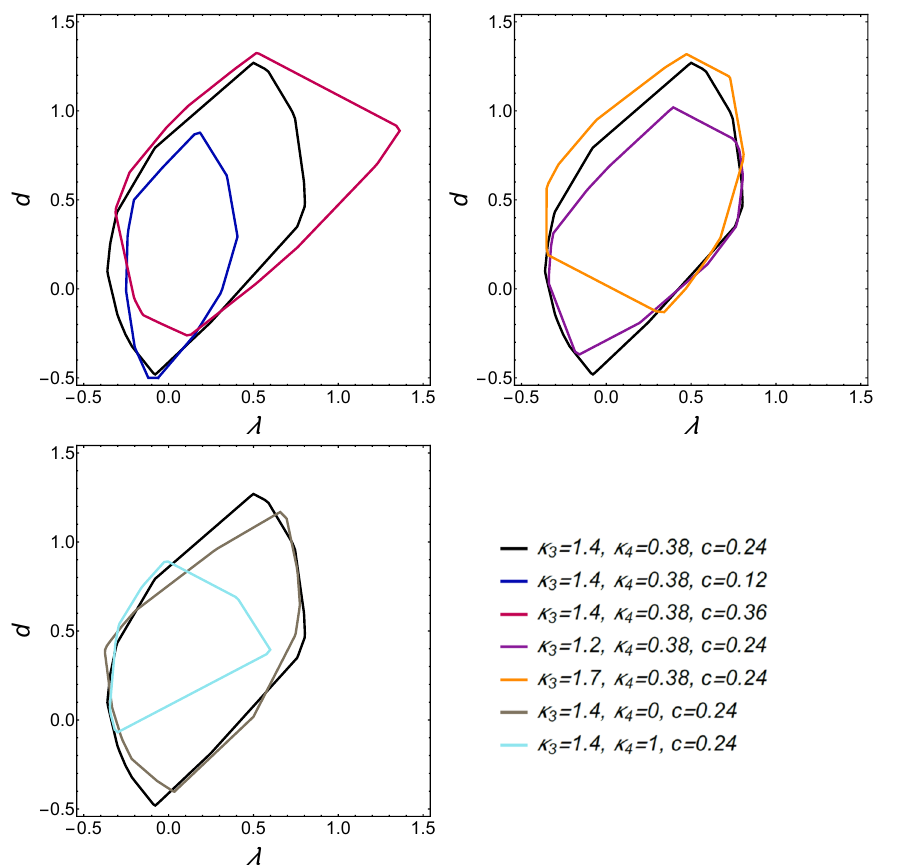
Figure 3 . Positive regions in the ( λ, d ) -plane with different κ 3 , κ 4 and c (the regions within the solid lines are allowed by generalized elastic positivity bounds) in the Z line is when parameters other than λ and d take their approximate central values in eq. (4.13). The top left, top right and bottom plot show the influence of changing κ